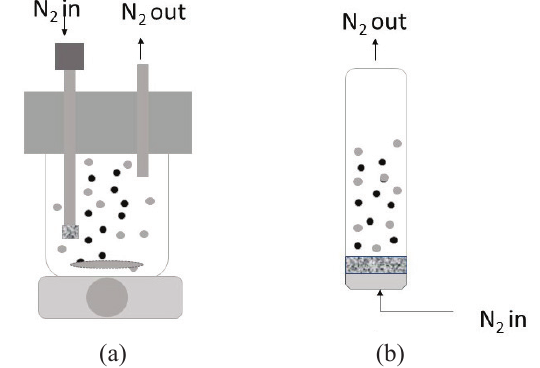
Fig. 1 – Reaction using N set-up consisting of Schott Duran bottle and stirrer, (b): set-up consisting of glass column with N